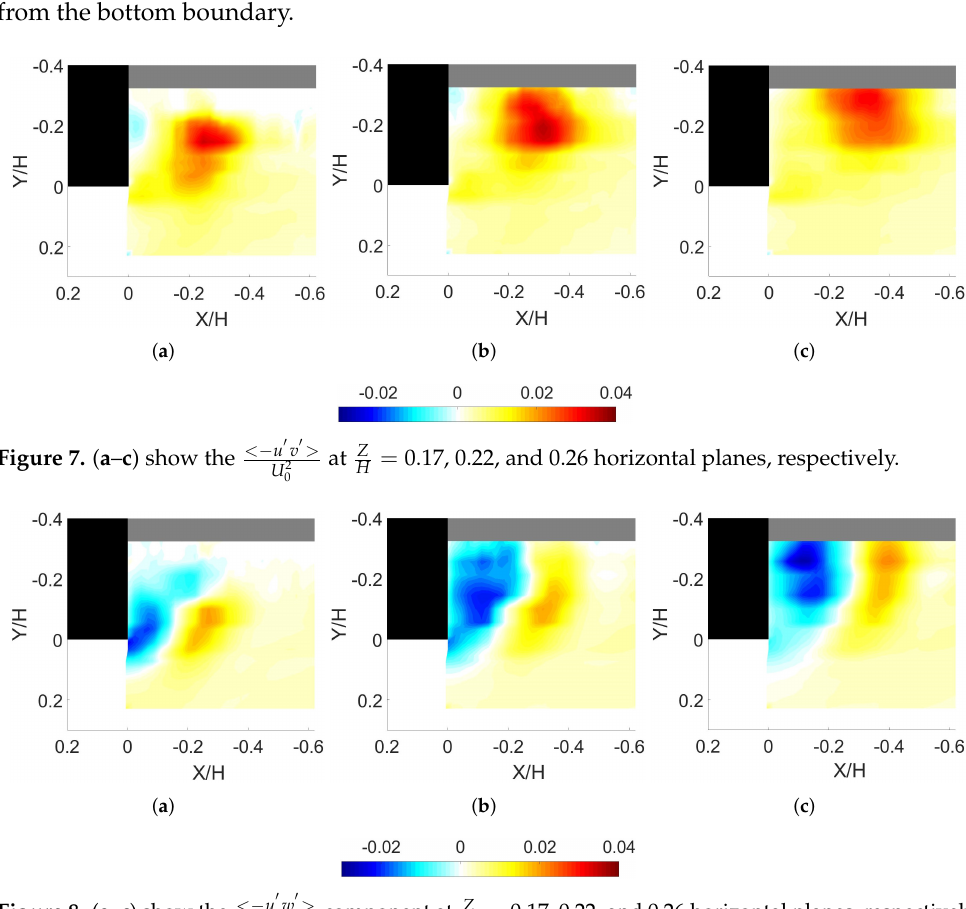
Figure 8. ( a – c ) show the < − u